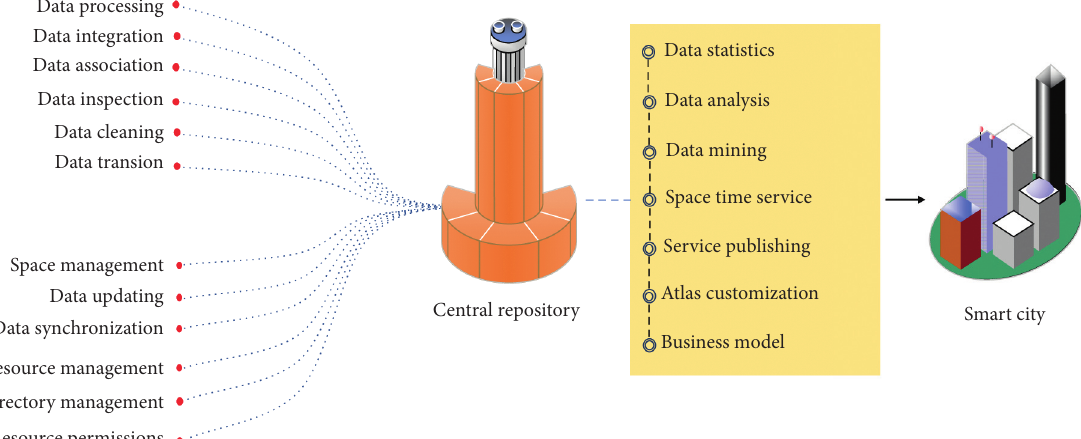
Figure 3: The overall design of smart city based on big data